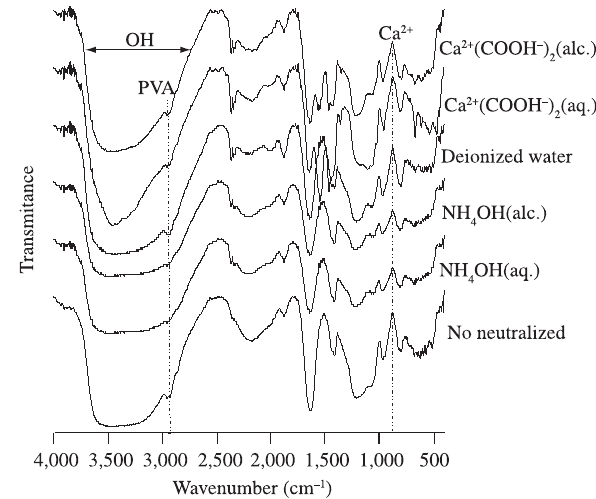
Figure 3. FTIR Spectra obtained from foams with 20 wt. (%) of PVA, without neutralization and after the neutralization tests.